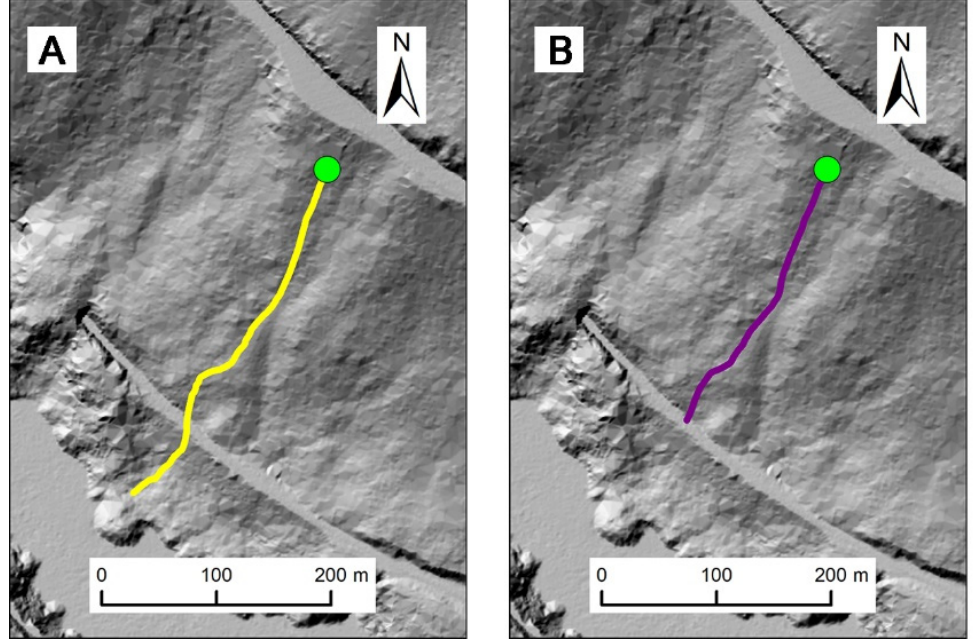
Figure 4. Rockfall simulations using RA: ( A ) in ArcGIS 9.x and ( B ) in ArcGIS 10.x.